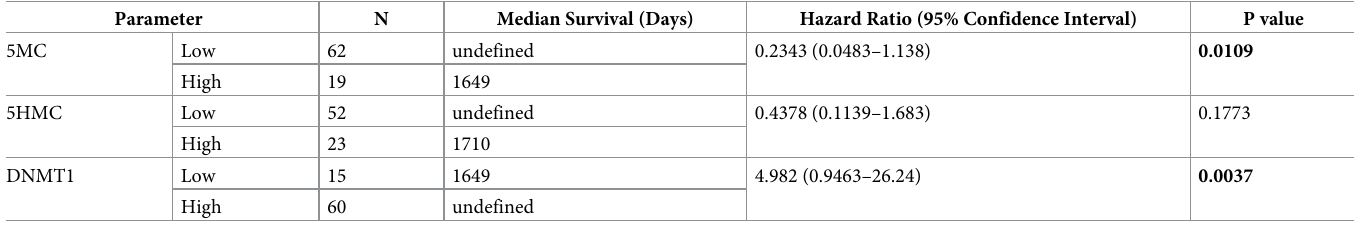
Table 4. Logrank analysis of overall survival for Kiupel’s grading system high grade cases only ¶ .